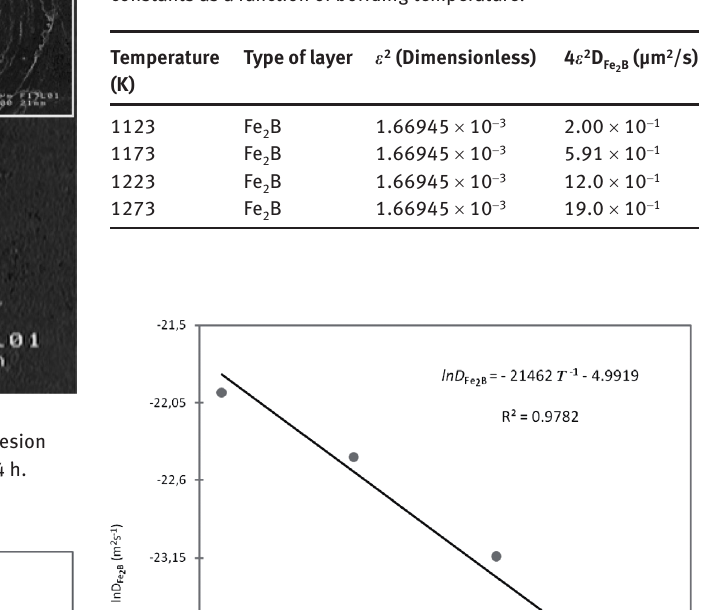
Table 1: The square of normalized growth parameter and growth constants as a function of boriding temperature.